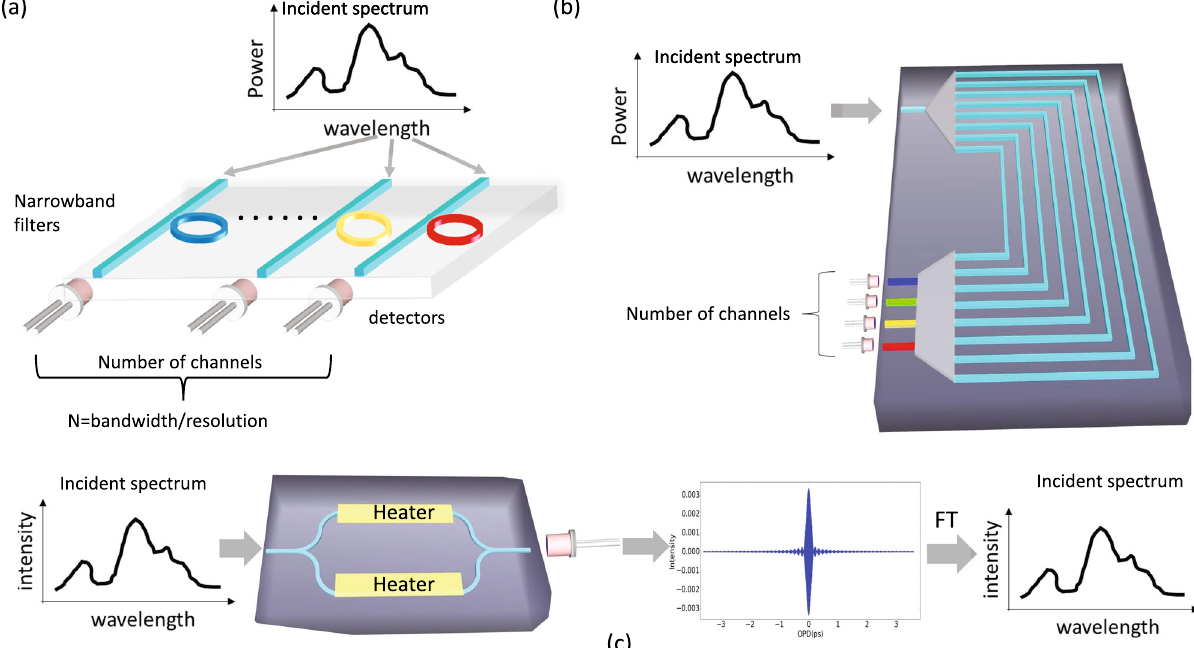
Fig. 1 Conceptual illustrations of different types of spectrometers. A schematic diagram describing the conventional split-and-detect spectrometers consisting of ( a ) narrowband fi lters array or ( b ) dispersive grating for fast spectrum reconstruction. The number of required channels is linearly proportional to the ratio of reconstruction bandwidth and resolution. The Fourier transform spectrometer (FTS) implemented on silicon photonics platform shown conceptually in ( c ) is used to generate and detect an interferogram (i.e., the autocorrelation of the input signal displayed by the left part of ( c )) by changing optical path delay (OPD) between two arms of a balanced Mach – Zehnder-Interferometer (MZI) using integrated heaters. The spectrum of the input signal on the right part of ( c ) can be retrieved by performing a Fourier transformation (FT) of the